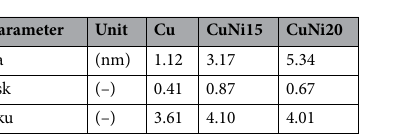
Table 2. Relevant height-based topographical parameters of the